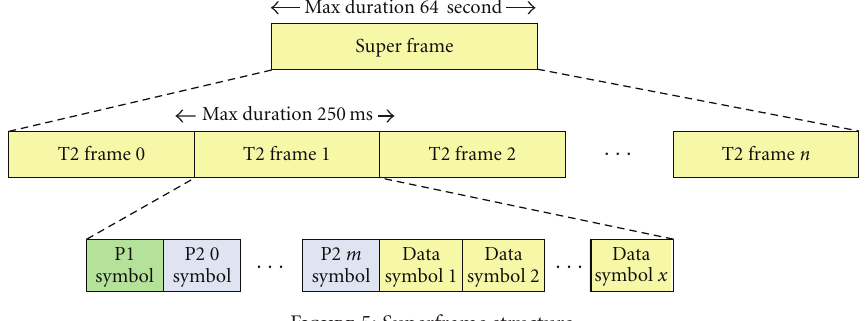
Figure 5: Superframe structure.